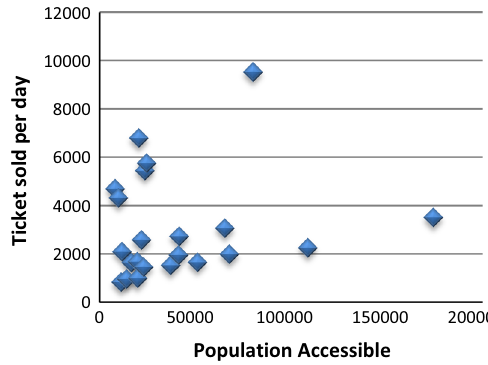
Fig. 3 Scatter plot of ticket sold per day versus population accessible